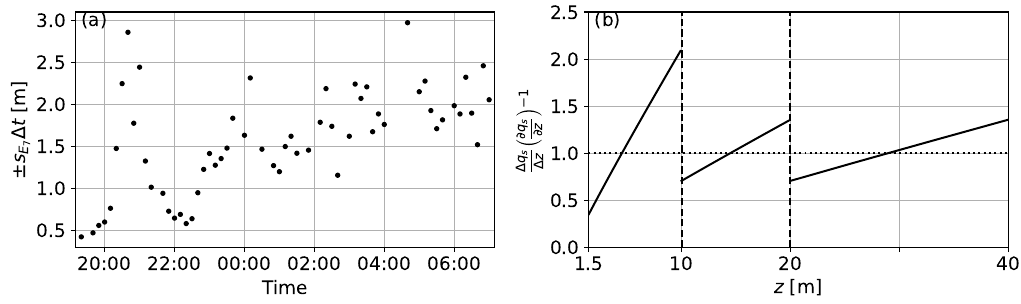
Figure A1. ( a ) Estimated uncertainty in the projected growth of fog for the CESAR observations presented in Figure 5b based on instrument precision. ( b ) Ratio of discrete to exact vertical gradient of q s assuming a logarithmic temperature profile, and over the first three depth ranges at